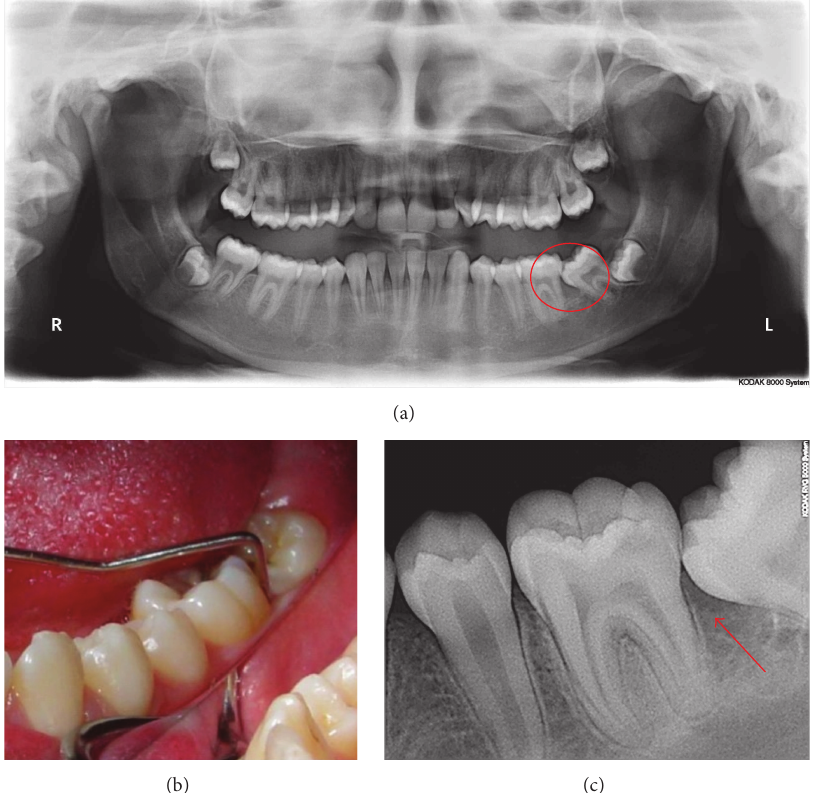
Figure 1: (a) Radiographic view of baseline (red circle showing defect side), (b) clinical view of defect side with periodontal probe, and (c) radiographic view of defect side (red arrow showing bone